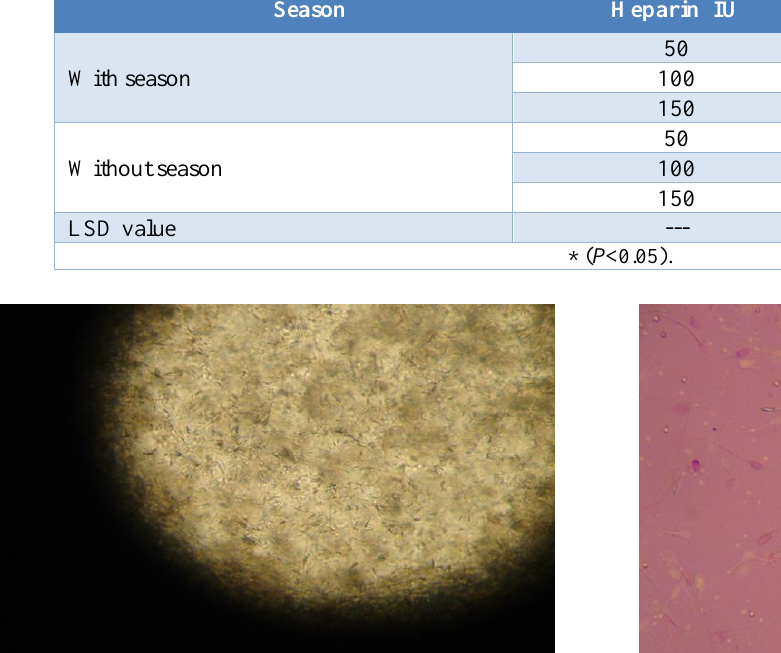
Figure, 3: Capacitated spermatozoa.